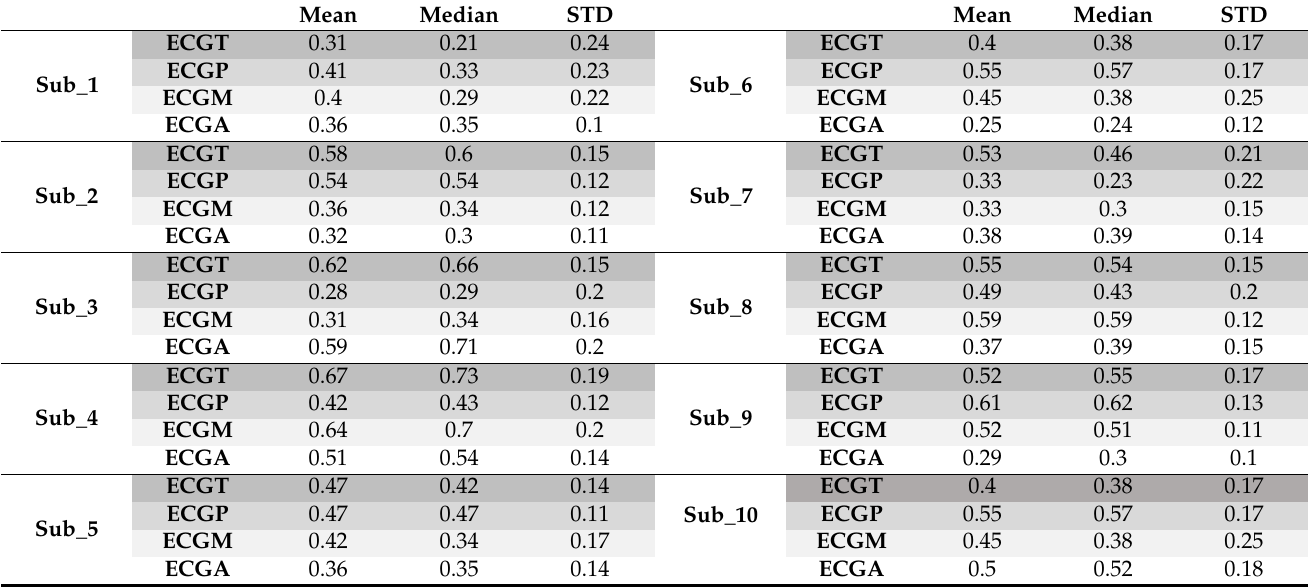
Table 2. Statistical features of 10 subjects.